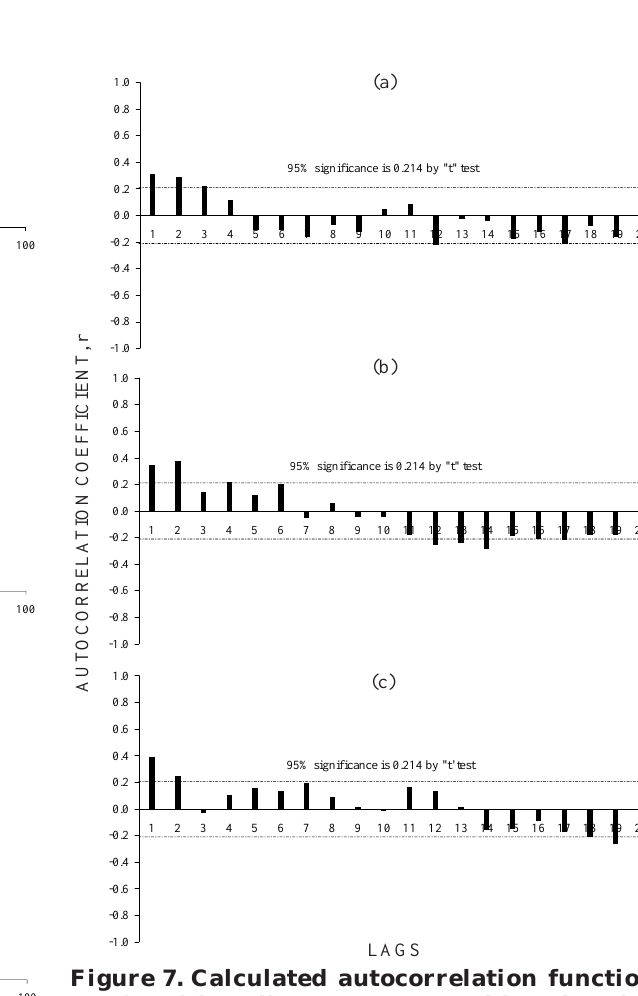
Figure 7. Calculated autocorrelation function (ACF) for soil water content residues data (a); soil organic matter residues (b); and clay content residues data of figure 6c (c).